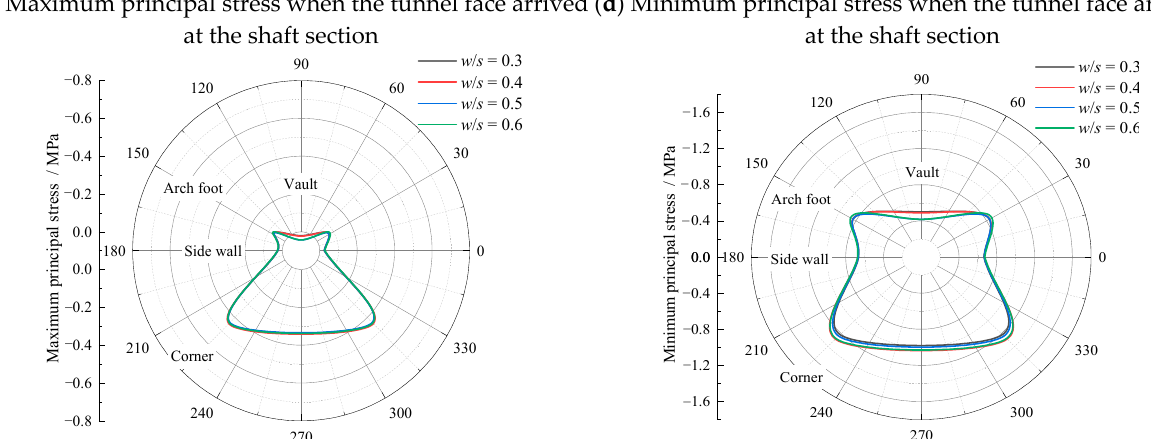
( f ) Minimum principal stress when the tunnel face left the shaft section Figure 22. Diagram of maximum and minimum principal stresses under different width–span ratios.